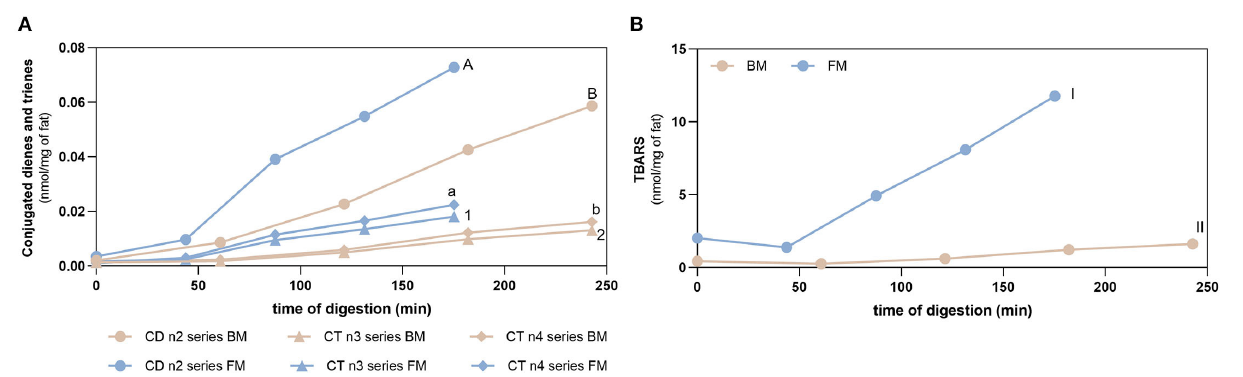
FIGURE 5 | Fat oxidation. Formation of conjugated dienes (CD, n2 series) and conjugated trienes (CT, n3, and n4 series) (A) and TBARS (B) during gastric digestion of beef and fish meal diets. Data are presented as the average ± SD of four replicates ( n = 4). Parametric ( t -test) statistical tests were applied to compare FA oxidation at the end of gastric digestion between beef or fish meal diets, and statistical differences ( p < 0.0001) are indicated using different letters or numbers (uppercase letters for CD n2 series, lowercase letters for CT n4 series, Arabic numbers for CT n3 series, and Roman numerals for TBARS values).